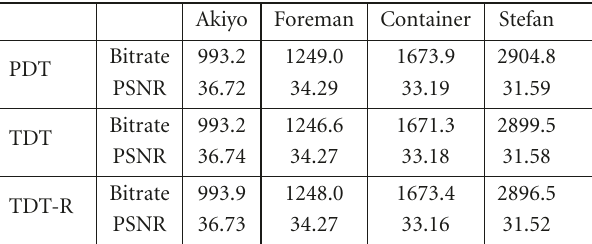
Table 3: RD performance comparisons with QP = 33. Bitrate: kbps, PSNR: